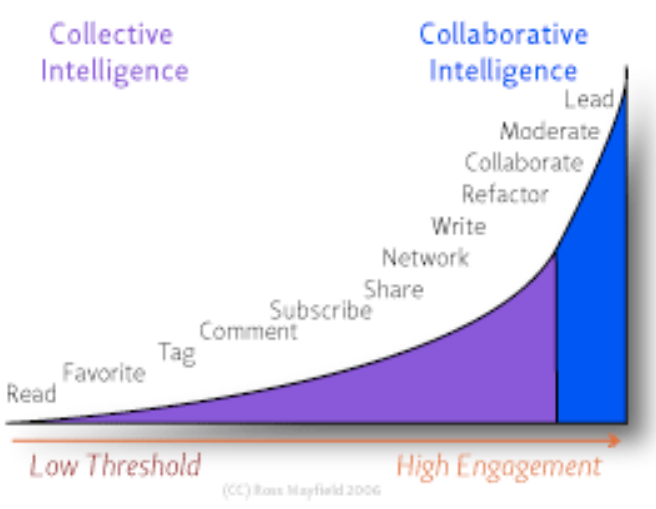
Figure 1: Ross Mayfield’s ‘Power Law of Participation’